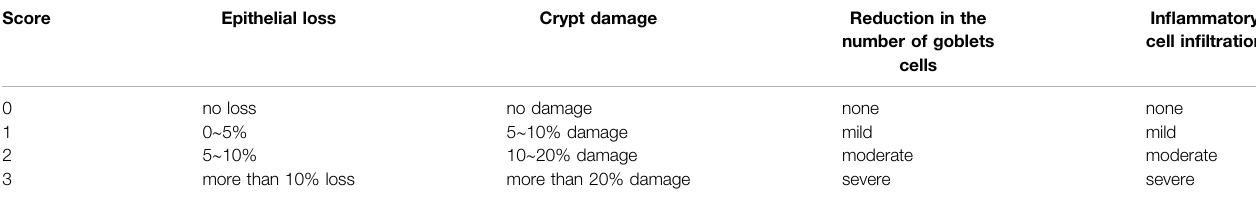
TABLE 2 | Histological grading criteria.